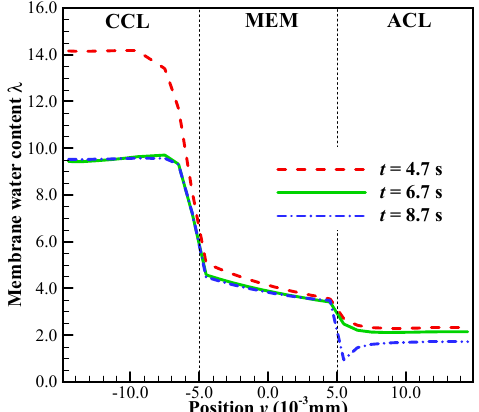
Figure 9. In process P1, the distribution of the membrane water content along the thickness of CCL, MEM and ACL at different time. The cell starts from − 20 °C with initial membrane water content λ = 5.0 and current density I = 0.30 A/cm 2 . The cell is supplied with dry hydrogen and oxygen. The stoichiometry ratio of the mass flow rate is 2.0 for both anode and cathode sides. The background pressure is 1.0 atm at both the anode and cathode outlets.